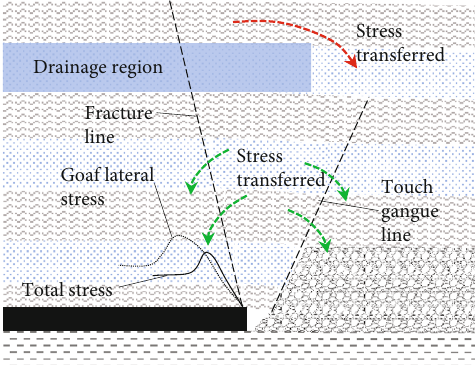
Figure 6: Stress evolution of roadway along goaf located in drainage depressurization